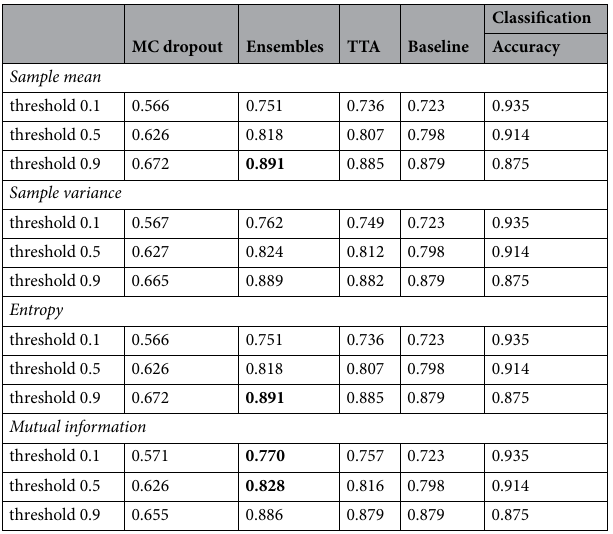
Table 4. Camelyon16 data: ROC-AUCs of misprediction detection for varying classification thresholds. The highest achieved values per classification threshold are in bold.